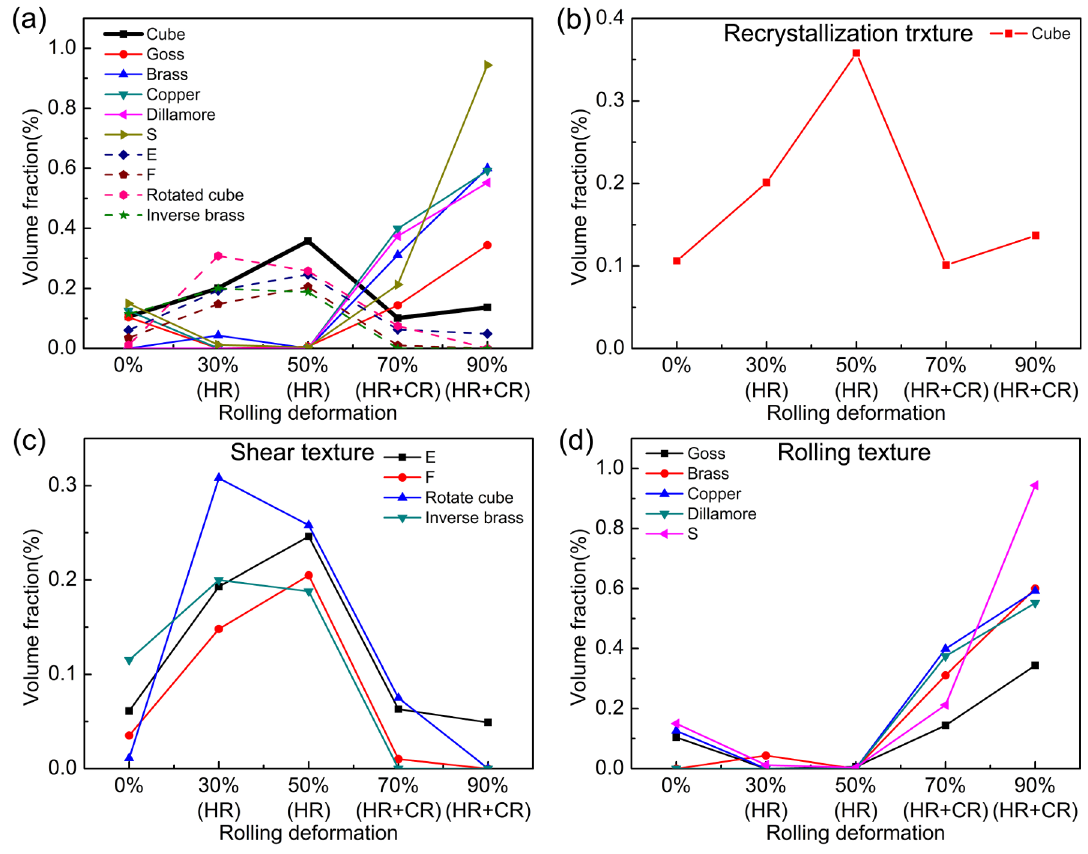
Figure 4. The variations in the volume fraction of (a) all the textures, (b) recrystallization texture, (c) shear texture and (d) rolling texture with increasing the rolling